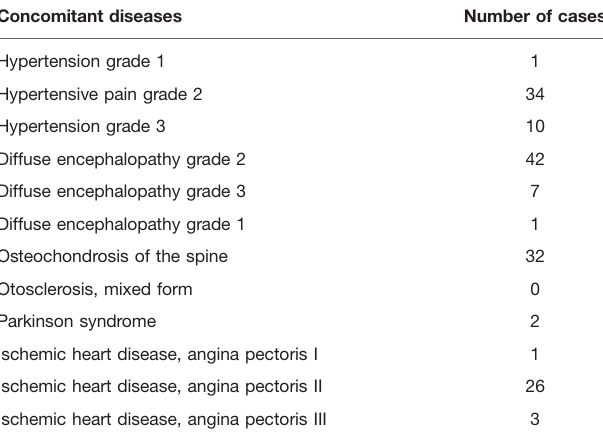
TABLE 1 | Comorbidities identi fi ed in the study